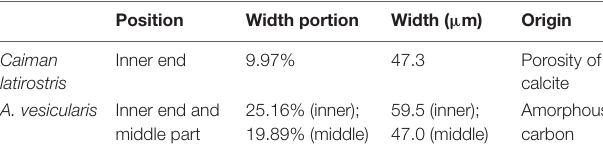
TABLE 3 | Comparison between the dark bands of Caiman latirostris (crocodyliformes) eggshell and A. vesicularis. Position Width portion Width ( µ